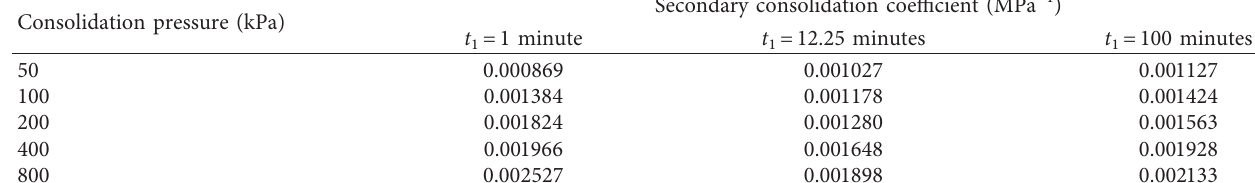
Table 6: Calculation table of secondary consolidation coefficient according to saturated expansive soil theory.